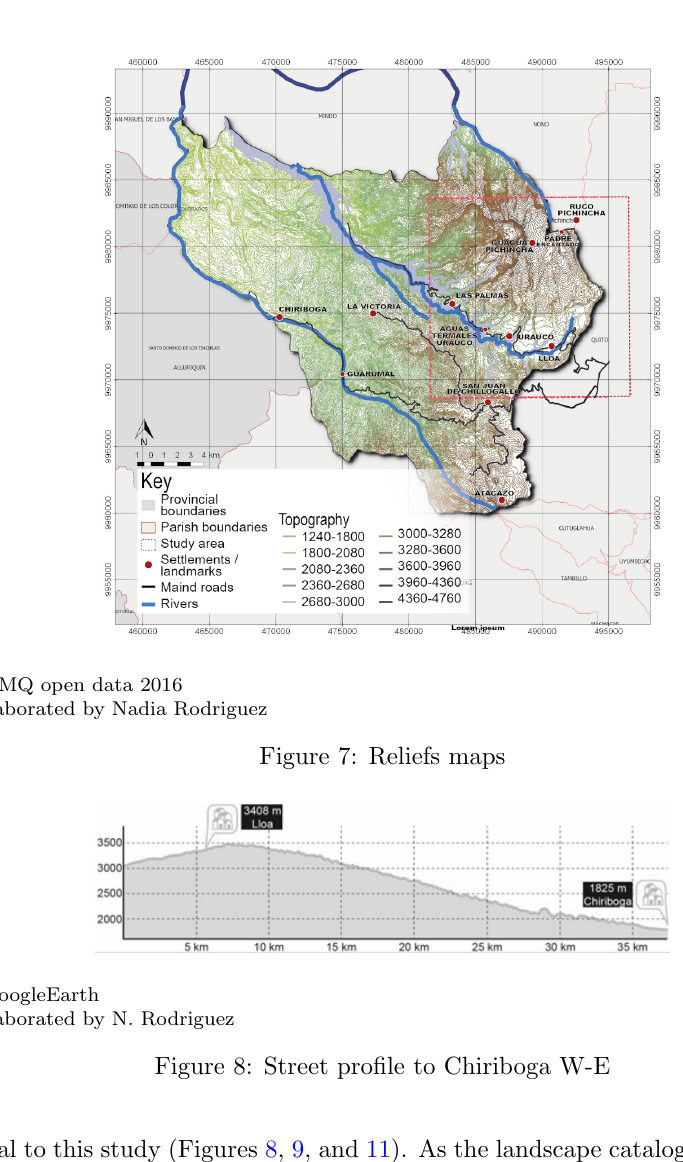
Figure 8: Street profile to Chiriboga